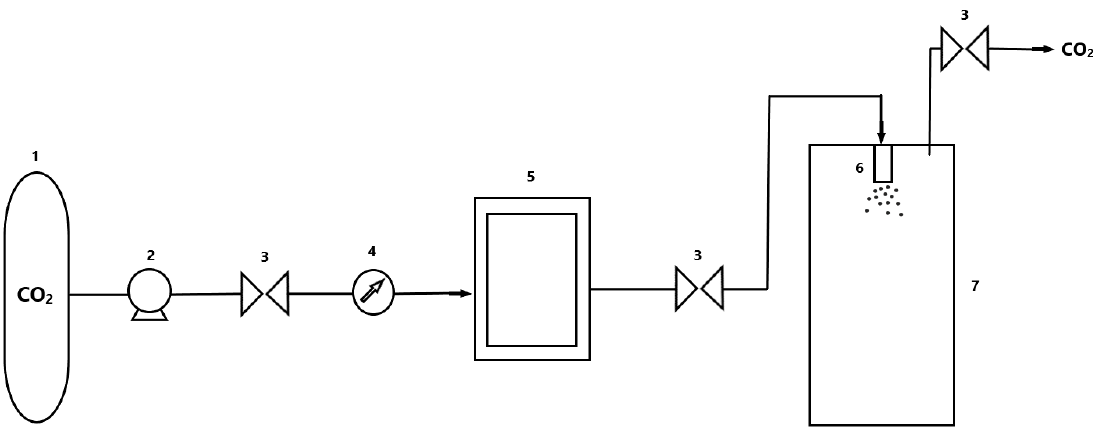
Figure 3. Rapid expansion of supercritical solution (RESS) process installation diagram. Legend: (1) CO 2 tank; (2) pump; (3) valve; (4) temperature control; (5) tank with agitator; (6) nozzle; (7) separating tank.